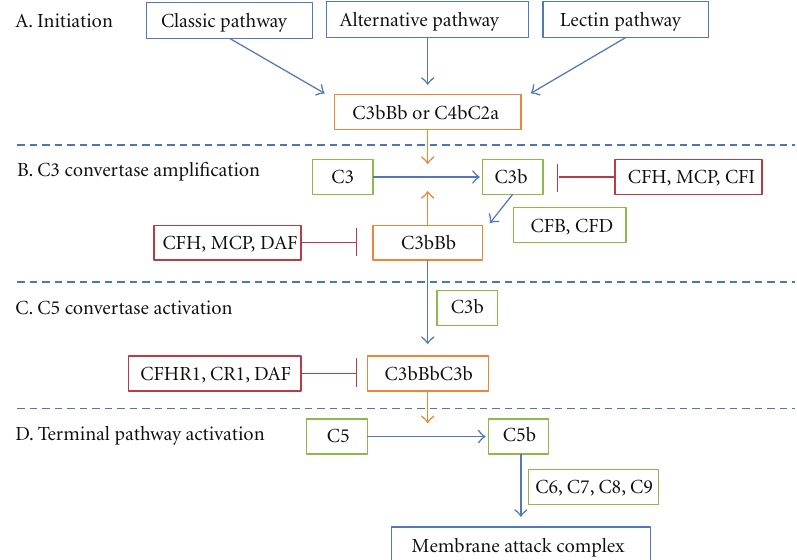
Figure 1: The complement system and its regulators. The complement system has four main steps. (A) Classical, alternative, or lectin pathway activation produces C3 convertases (C3bBb or C4bC2a) to initiate the complement cascade. (B) C3 convertase cleaves C3 into C3a and C3b. CFB binds to C3b and is cleaved by CFD into Bb, forming a new C3 convertase, C3bBb. This amplification step is tightly controlled by multiple regulators of complement (e.g., CFH, MCP, DAF, and CFI). (C) Once C3 convertase amplification is allowed to proceed, additional C3b is generated, ultimately forming C5 convertase, C3BbC3b. (D) C5 convertase cleaves C5 into C5b, which recruits C6, 7, 8, and 9 to form the membrane attack